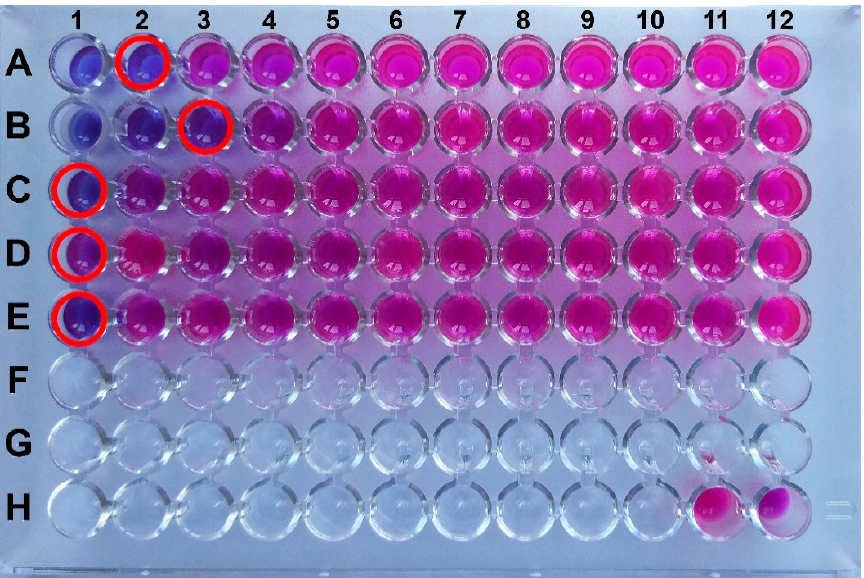
Figure 2. Assessment of minimum inhibitory concentrations (MICs) for aqueous extracts of essential oils (AqEOs) against E. faecalis : A—Oregano; B—Thyme; C—Lemongrass; D—Clove; E—Melaleuca; H11- positive control; H12—negative control. The concentration of AqEOs in columns 1–12 ( v/v ) are: 50%, 25%, 12.5%, 6.25%, 3.125%, 1.56%, 0.78%, 0.4%, 0.2%, 0.1%, 0.05% and 0.025%.